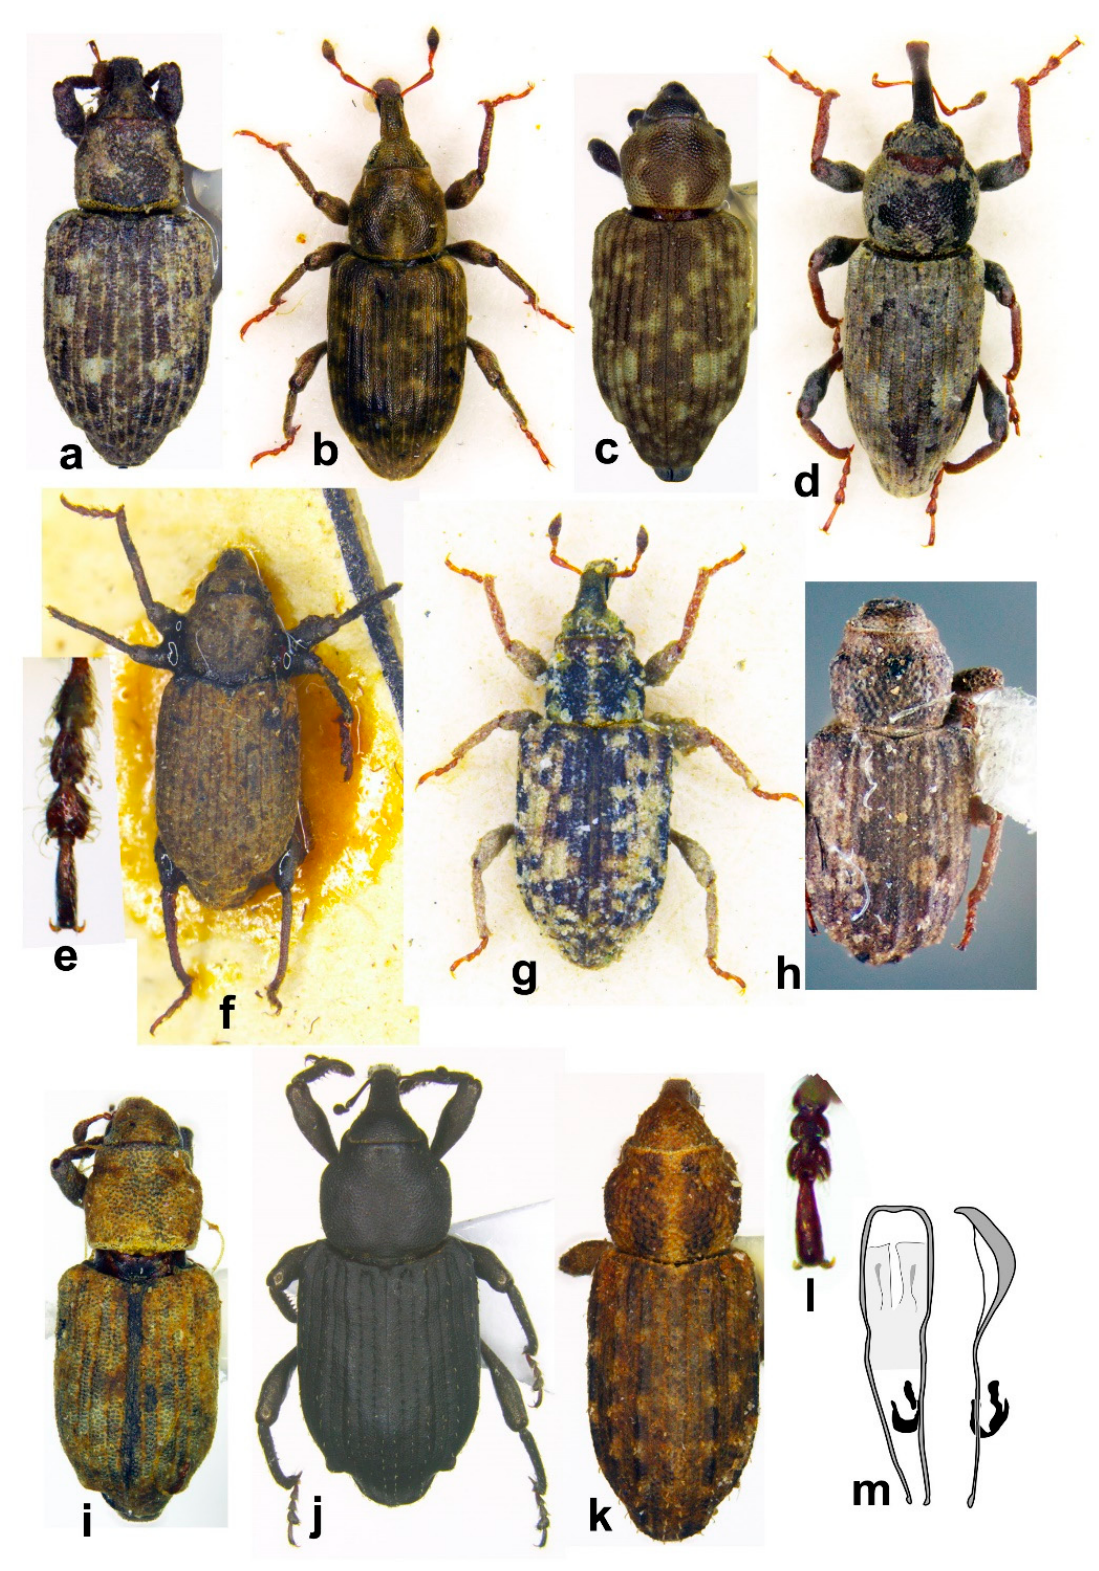
Figure 7. Habitus in dorsal view of ( a ) Bagous bagdatensis , male; ( b ) Bagous argillaceus , male; ( c ) Bagous biimpressus , female; ( d ) Bagous mingrelicus , female; ( e ) Bagous lyali , tarsus, male; ( f ) Bagous lyali , male; ( g ) Bagous subruber , male (IRAQ: Basra, 1.iv.1936, Frey, ZSMU); ( h ) Bagous septemcostatus , male; ( i ) Bagous tempestivus , male; ( j ) Bagous validus , male; ( k ) Bagous libanicus , female; ( l ) B. libanicus , tarsus; ( m ) B. libanicus , aedeagus (not on the same scale). Note: Bagous argillaceus is the only species among the Israeli aquatic weevils that occurs in the desert. This species is distributed widely throughout the Palaearctic region, but is restricted to places with high salinity [26]. In spite of its wide distribution its host plant is unknown. In Israel it was found in two quite different habitats: an artificial freshwater reservoir in the Central Negev (Ma`agar Yeroham = Yeroham Reservoir, at 450 m a.s.l., with still water; and a spring with brackish water, flowing into the Dead Sea (‘En Boqeq), at − 350 m b.s.l., and resembling it in its high salinity of the banks and aridity of the area. In both places weevils were collected in light traps, in Ma`agar Yeroham one specimen was collected on the vegetation close to the water (Starke, pers. comm.). It can be assumed that B . argillaceus is associated with the same host plant in both localities. The vegetation of ‘En Boqeq